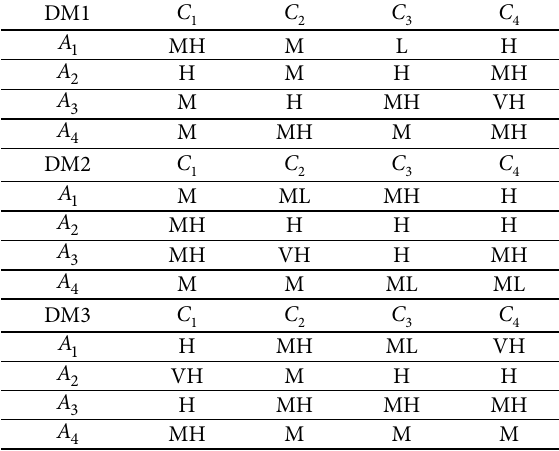
Table 3. individual decision